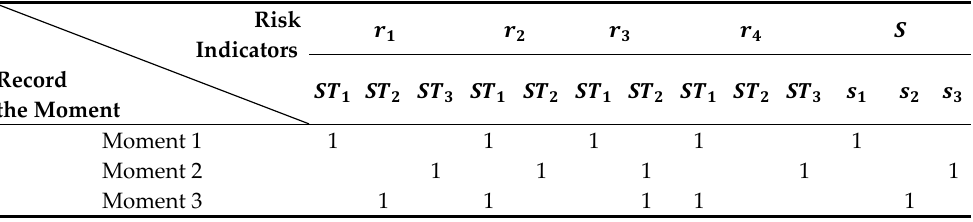
Figure 9. The project plan schematic diagram, prefabricated components, and the corresponding BIM model. Table 6. Continuous variable risk state division. Table 6. Continuous variable risk state